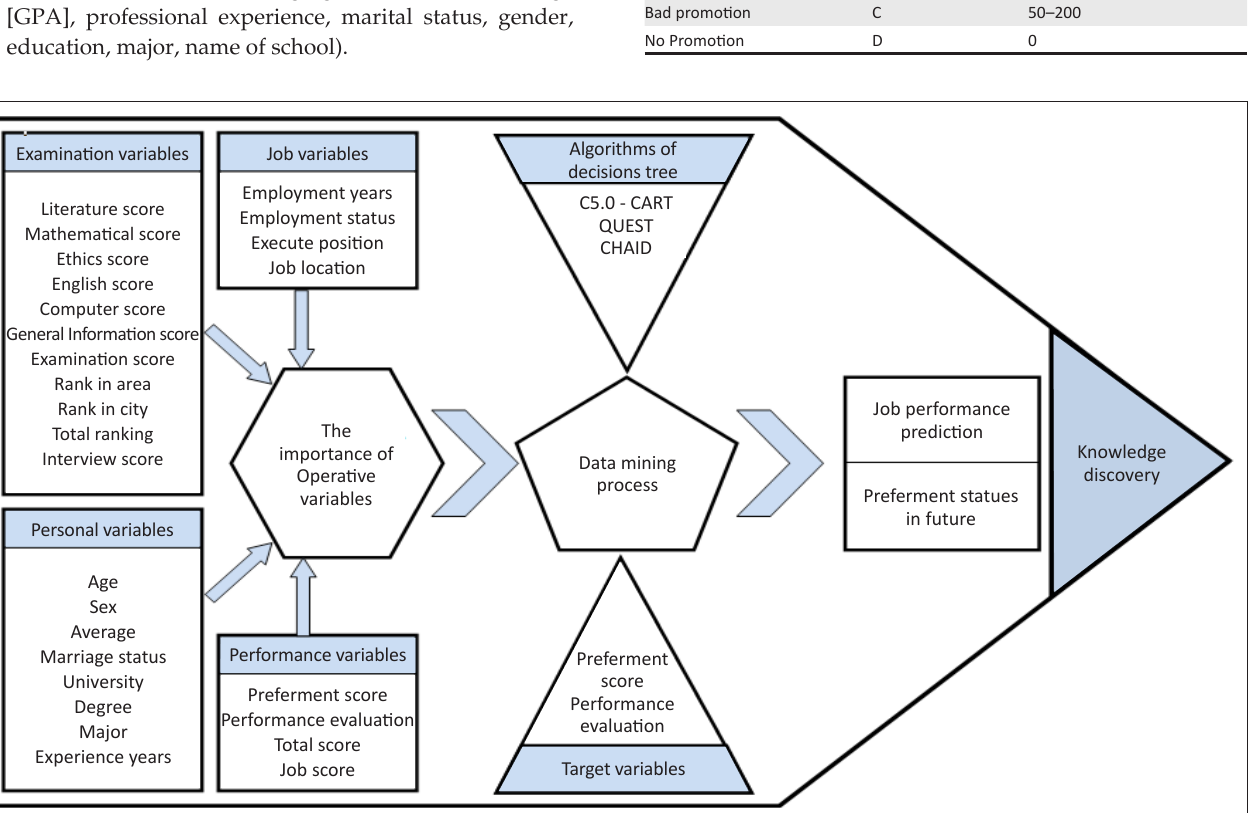
The importance of